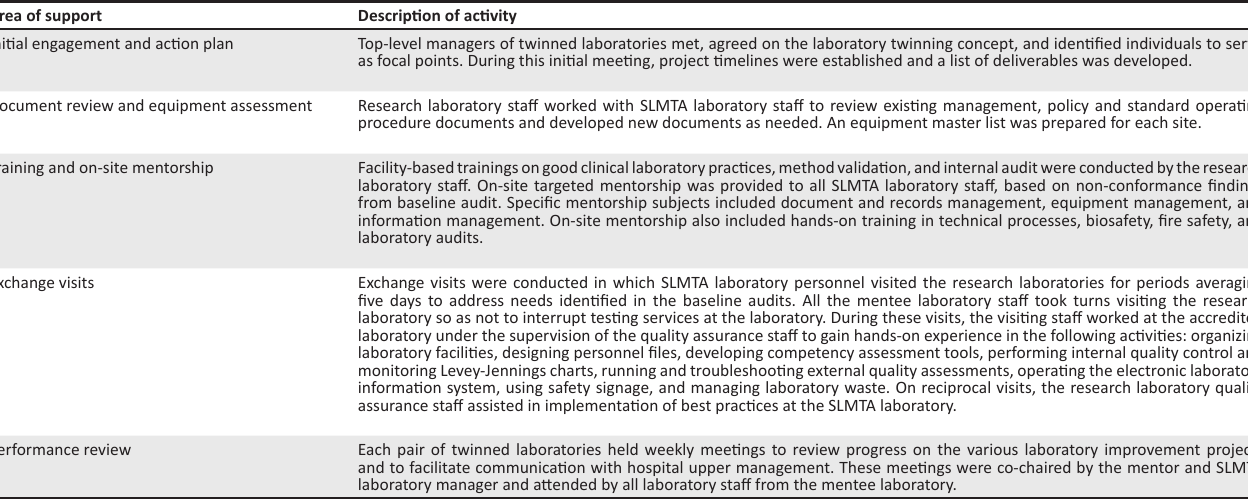
TABLE 2: Institutional mentorship